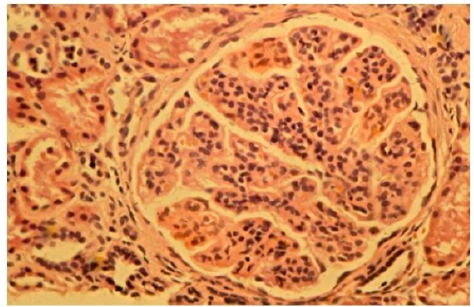
Figure 4. Kidney glomerulus with an increased number of cells and a well-defined lobular structure. H&E, 100 ×